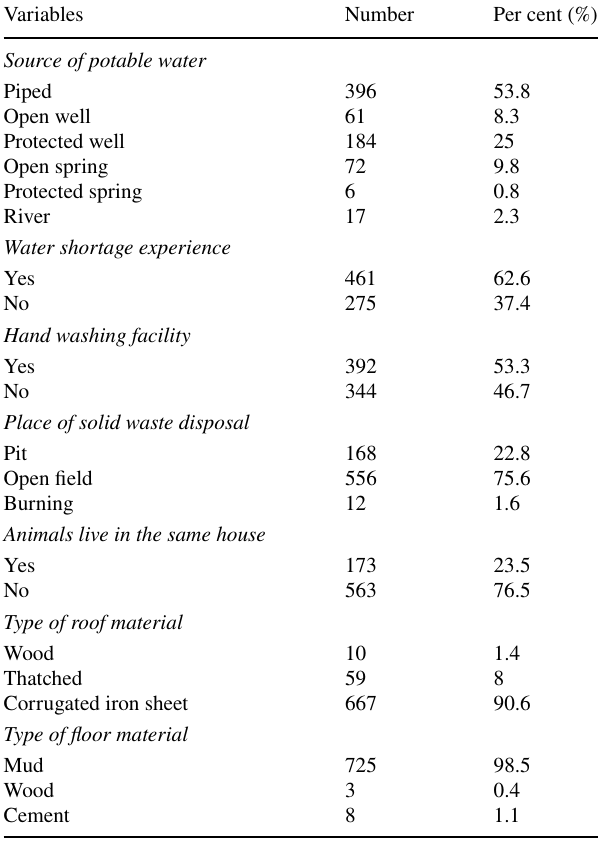
Table 2 Distribution of household environmental characteristics of respondents, North Gondar Zone, 2016 ( n = 736) Number Per cent (%)